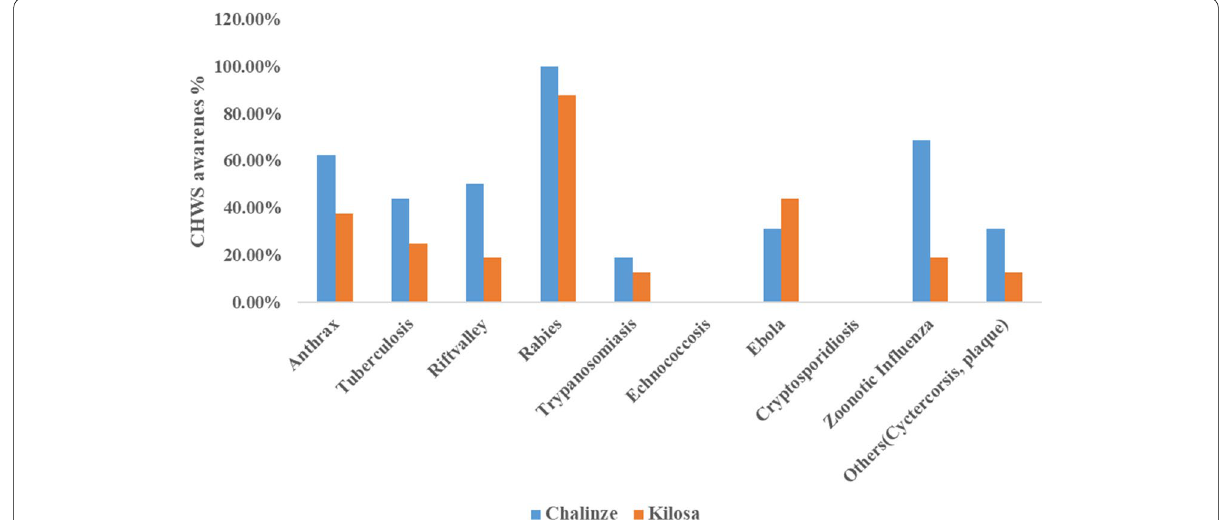
Fig. 3 Community health workers’(CHWs) awareness on other zoonotic diseases in Kilosa and Chalinze